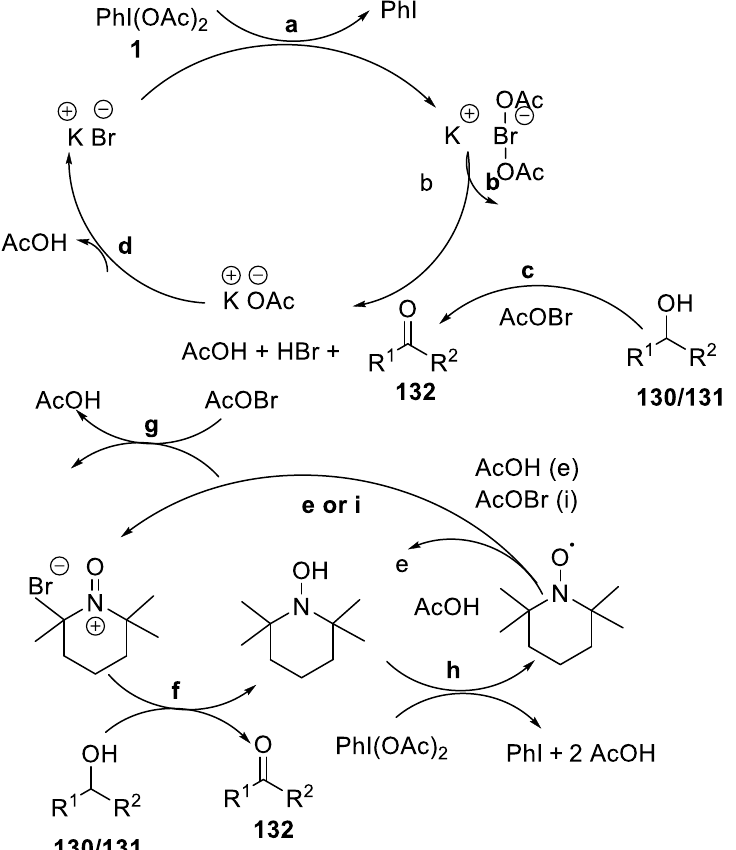
Figure 18. Proposed mechanism for the PIDA-mediated oxidation of alcohols.